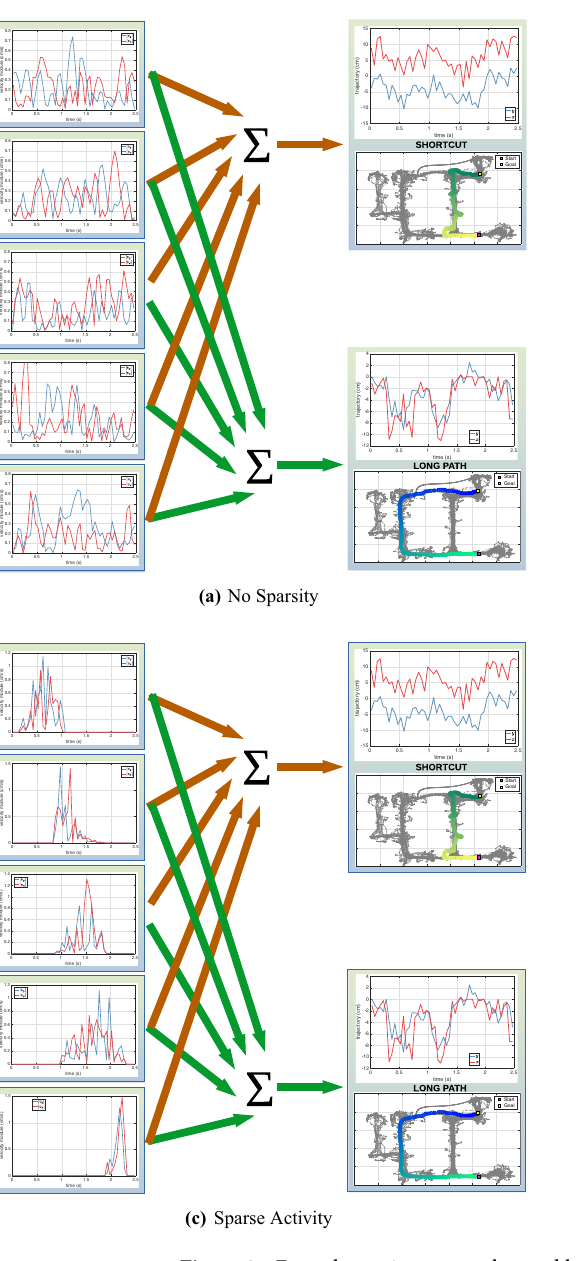
Experimental results, animal R01. In all the analyses below, we focus on trajectory data of animal R01 for illustrative purposes; see the Supplementary Material for data on animals R02 and R03, which show the same pattern of results as animal R01.